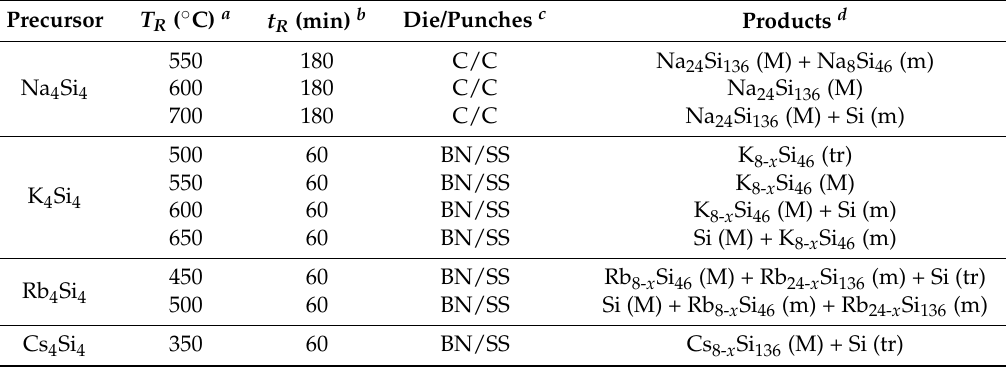
Table 1. Spark-plasma synthesis (SPS) conditions for the silicon clathrates.